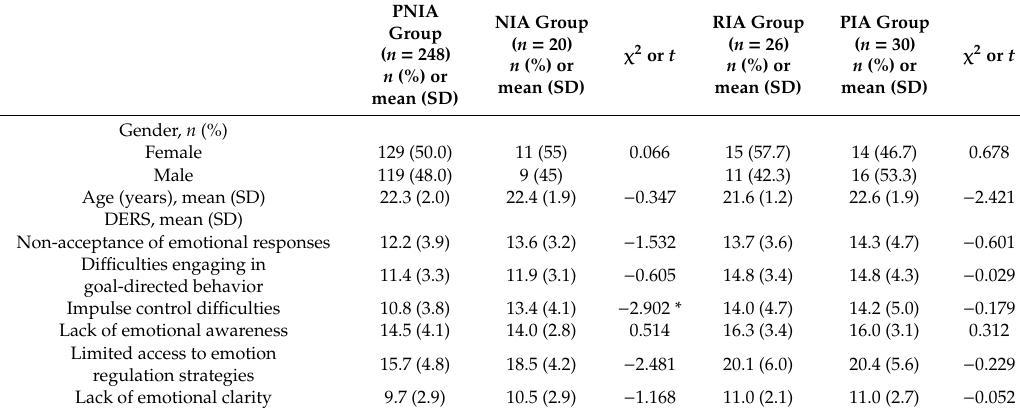
Table 2. Comparisons of demographic data and di ffi culties in emotion regulation between the PNIA and NIA groups and the RIA and PIA